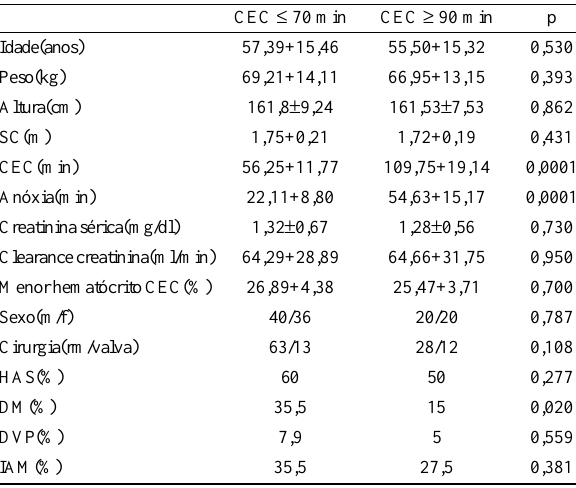
Tabela 2. Dados clínicos no